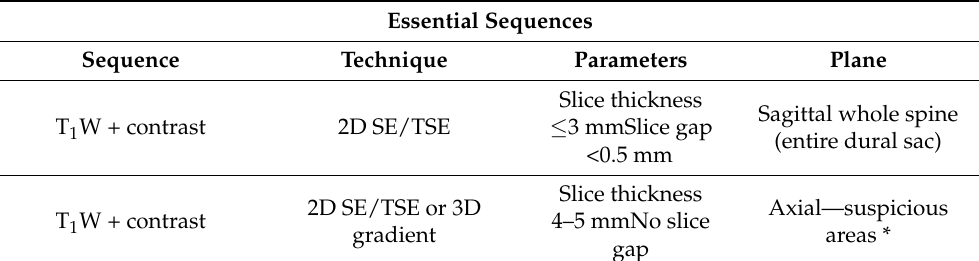
Table 2. Essential and optional spinal Magnetic Resonance Imaging sequences. * In primary tumours of the spinal cord, T and pre contrast T 1 W sequences are essential. ** The heavily weighted T sequence localised to a region of interest is useful in assessment of drop metastasis. SE, Spin Echo; TSE, Turbo Spin Echo; FSE, Fast Spin Echo; CISS, Constructive Interference in Steady State; bFFE, balanced Fast Field Echo; FIESTA, Fast Imaging Employing Steady-state Acquisition. Essential